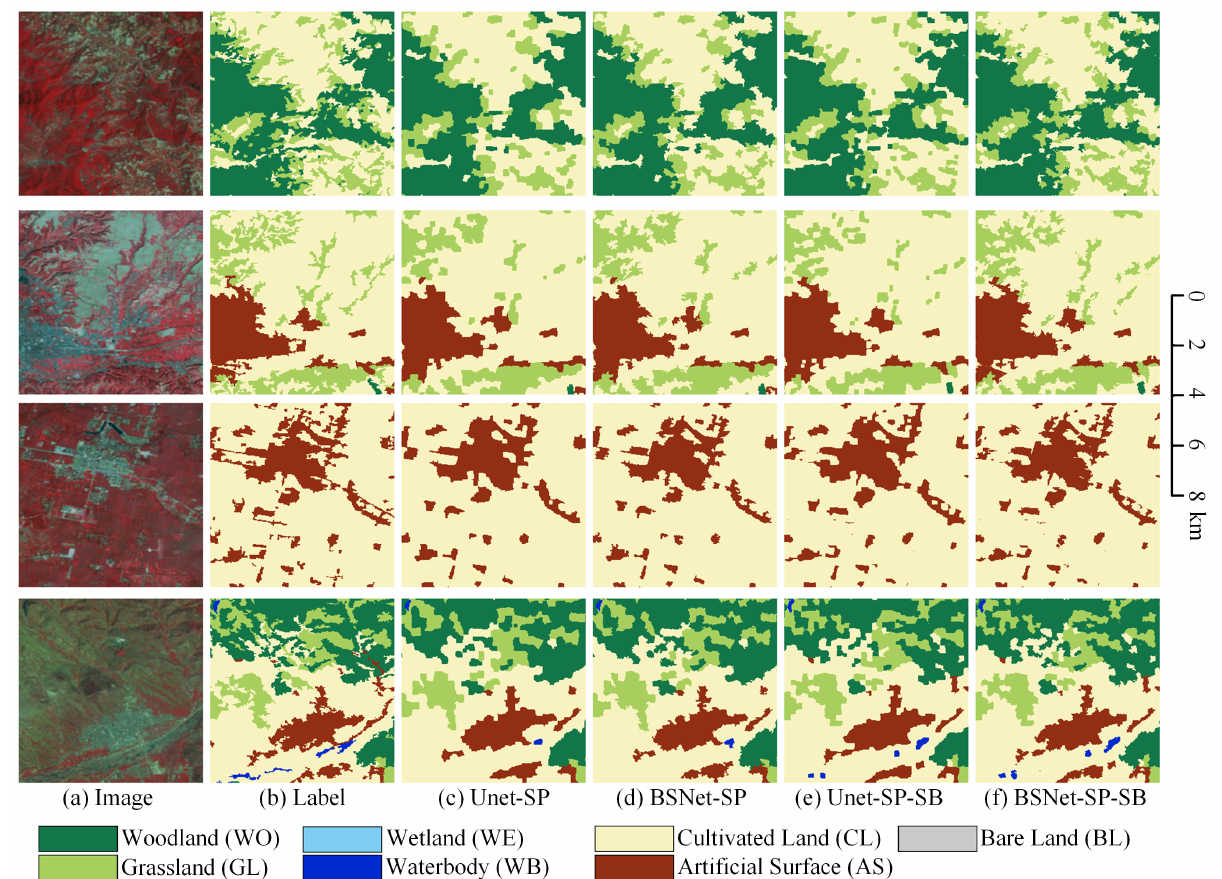
Figure 14. Ablation study with the self-boosting method on Landsat extend dataset. ( a ) Landsat image. ( b ) Ground truth. Inference result of ( c ) the UNet with the superpixel branch (UNet-SP), ( d ) the UNet-SP with the self-boosting method (UNet-SP-SB), ( e ) the BSNet with the superpixel